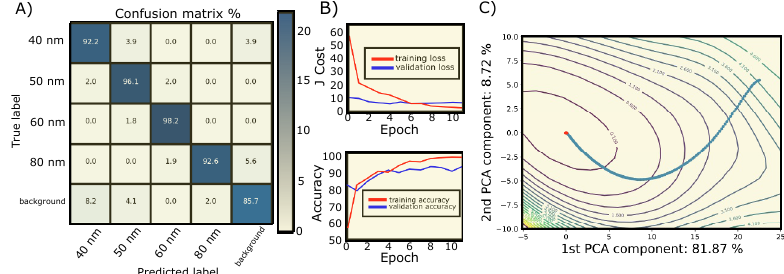
Figure 1. A) The accuracy for the test set in the confusion matrix. B) The training and validation loss - top and accuracy - bottom, is evaluated across di ff erent number of epochs based on the optimal architecture of the CNN model. C) 2D visualization of the loss surface of the CNN model with the projected learning trajectories using normalized PCA direction (batch size of 20, Adam optimizer and 15 epochs of